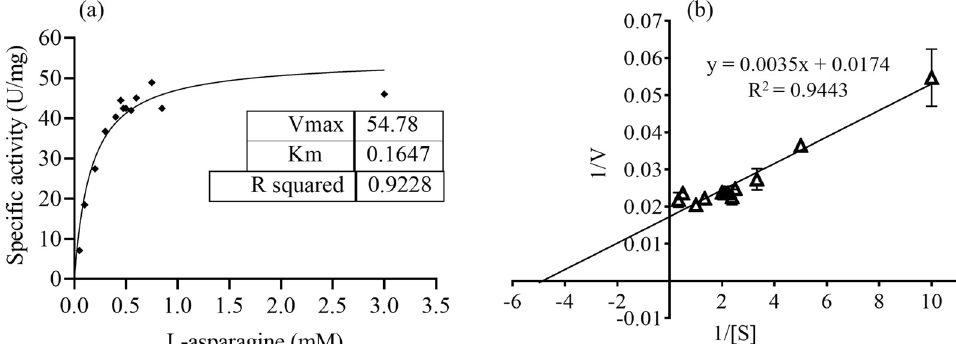
Fig. 5 Graphical representation of kinetic study of PCH199 L-ASNase. Determination of K m and V max of purified L-ASNase for L-asparagine by non-linear regression analysis of experimental steady-state data. a Plot of the reaction velocities (V) versus substrate concentration (S: 0.1– 3.0 mM) fitted to the Michaelis–Menten equation. b The corresponding Lineweaver–Burk plot ( K m